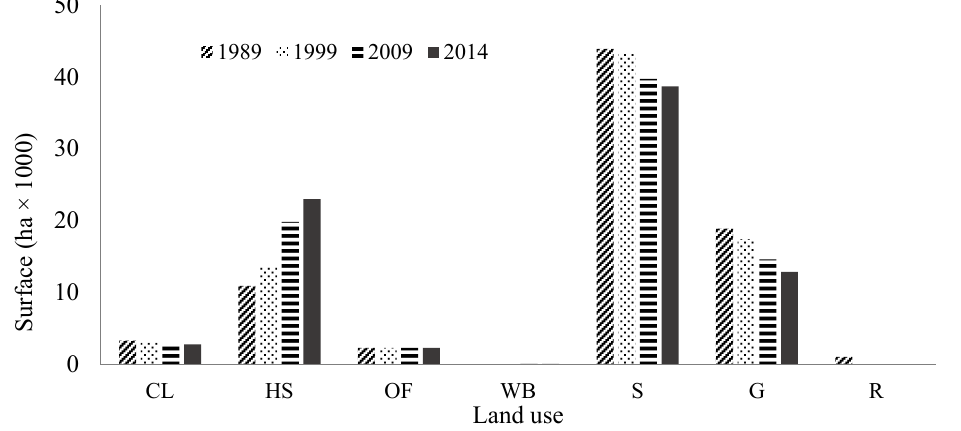
Figure 7. Growth dynamics of seven land use types in the urban and peripheral areas of Chihuahua City during 1989–2014. CL, Croplands; HS, Human settlements; OF, Oak forest; WB, Water bodies; S, Shrublands; G, Grasslands; R, Riparian vegetation.